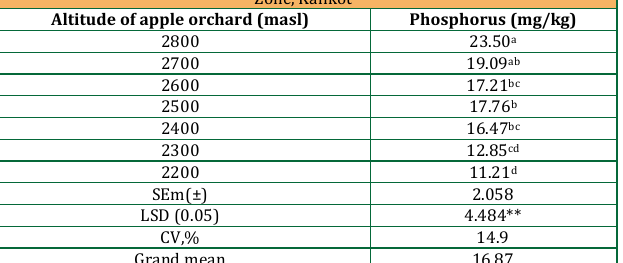
Table 8: Phosphorus variation in different altitude apple orchards in Apple Zone, Kalikot Altitude of apple orchard (masl)